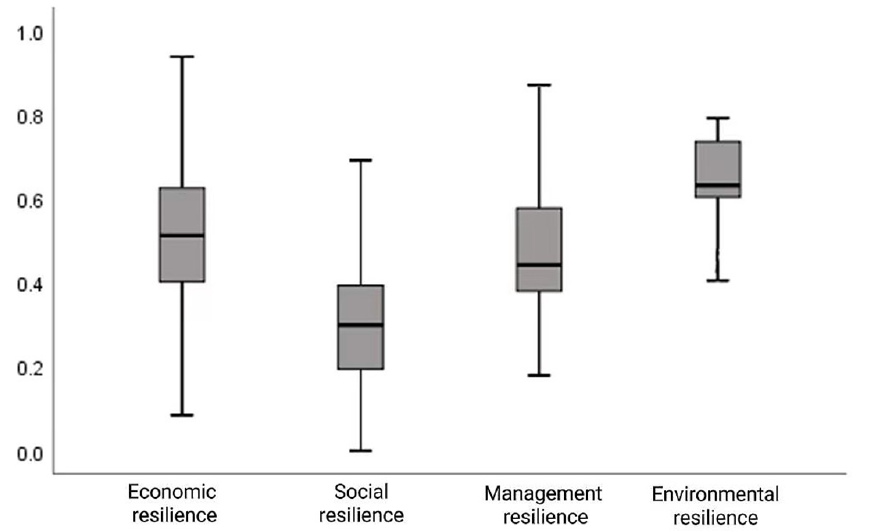
Figure 2. Dimensional boxplot of community resilience.